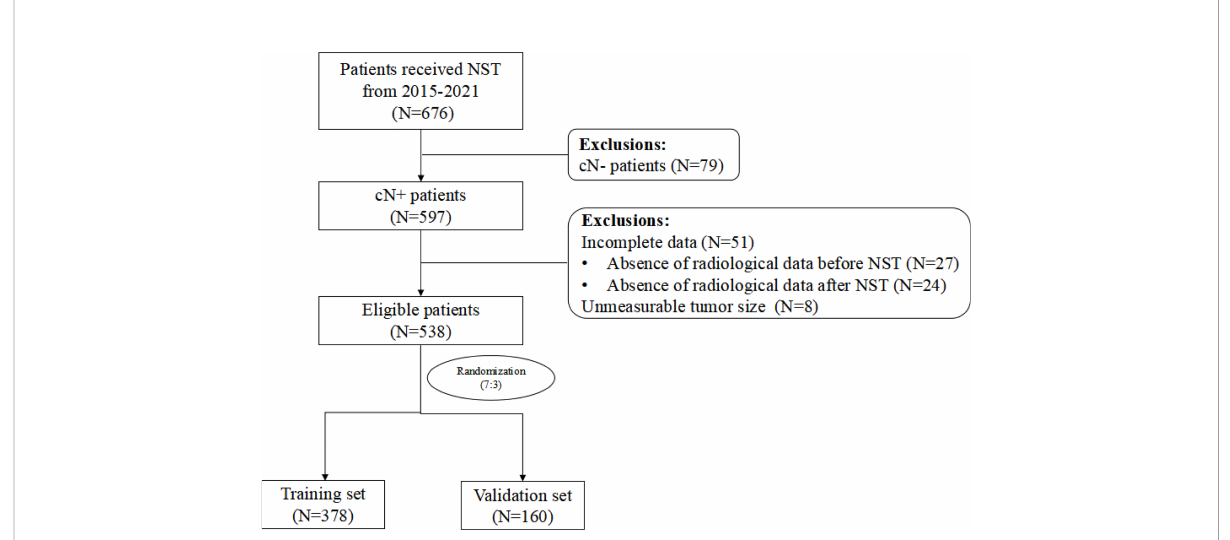
FIGURE 1 Study fl owchart NST, neoadjuvant systemic therapy; cN-, clinically node-negative; cN+, clinically